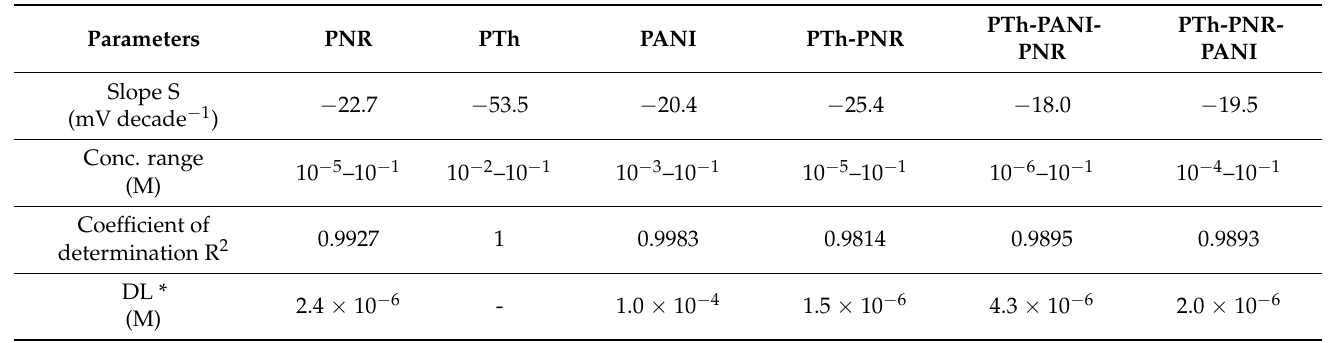
Table 4. Evaluation of potentiometric parameter values of prepared electrodes on the concentration of citrate ions.